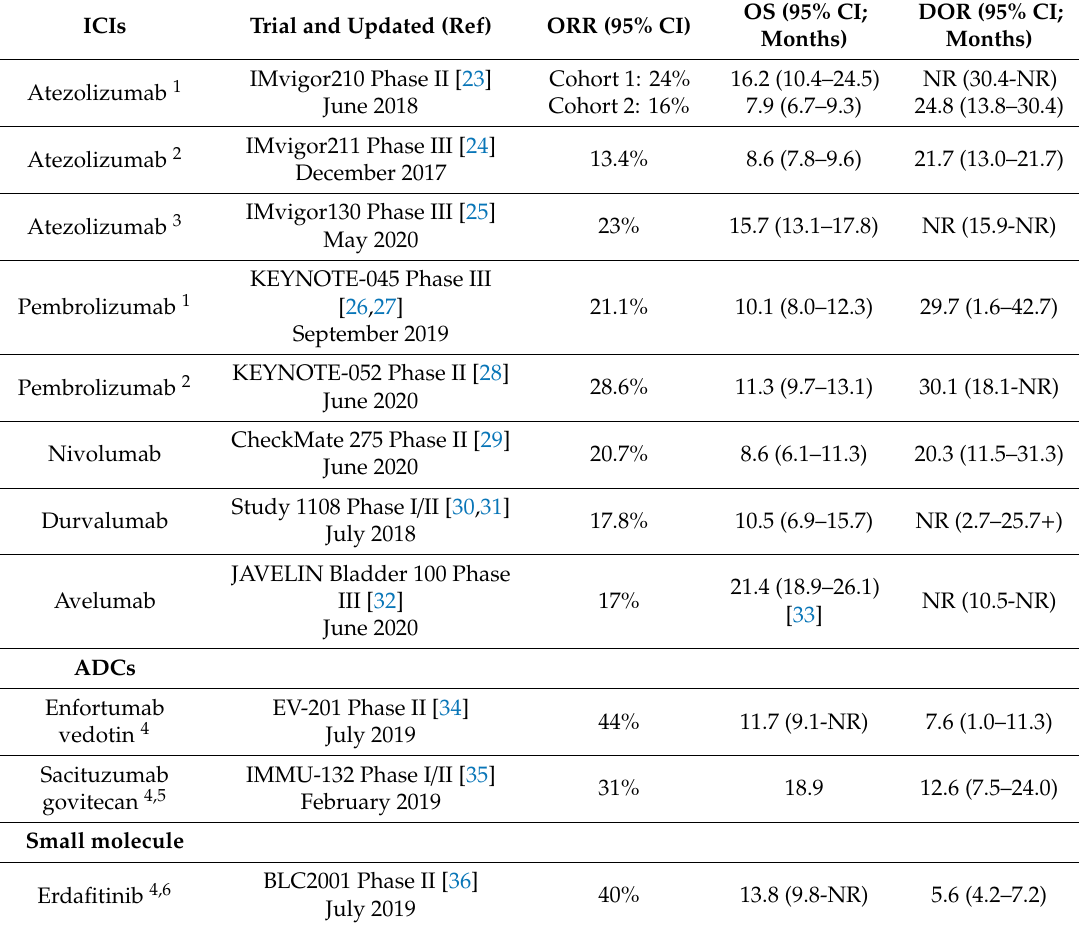
Table 1. Updated clinical trial ORR, OS, and DOR for ICIs and targeted agents as monotherapies. ICIs Trial and Updated